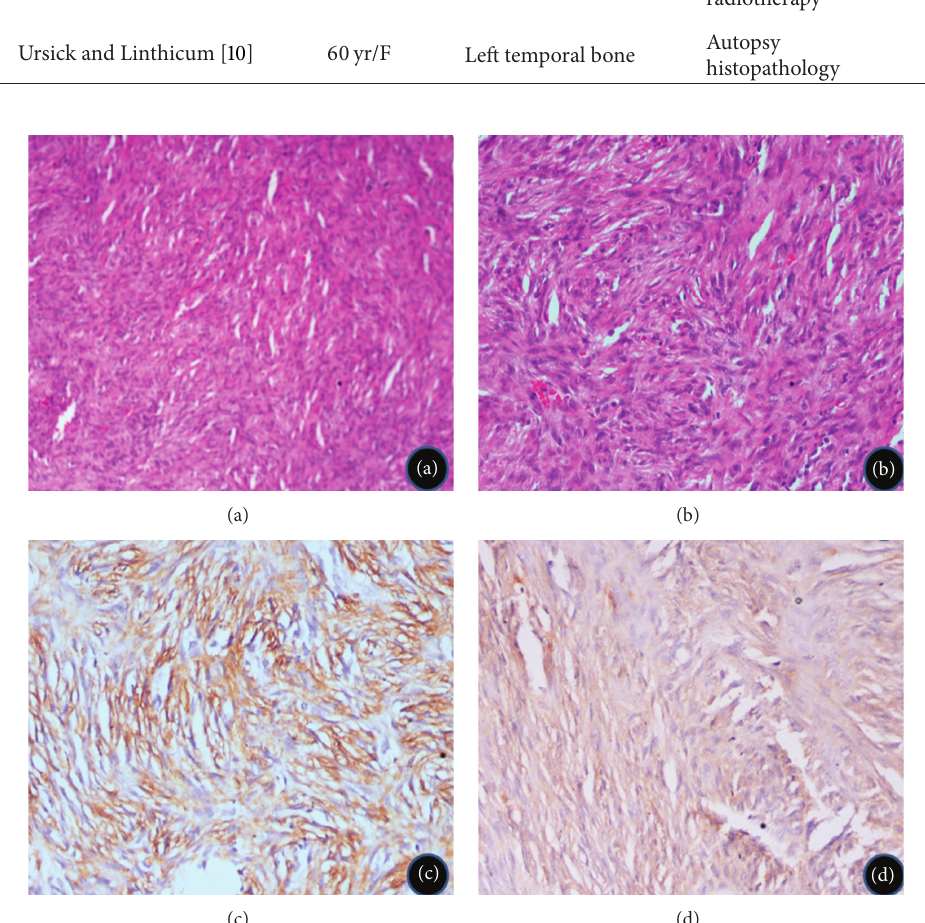
Figure 1: Microphotograph shows intersecting marginated groups of spindle tumor cell with elongated and blunt-ended nuclei. There is nuclear hyperchromasia and pleomorphism. ((a) H&E 100x, (b) 200x). The cells are immunopositive for smooth muscle actin ((c) IHC (SMA) 200x) and focally positive for S100 ((d) IHC (S100)